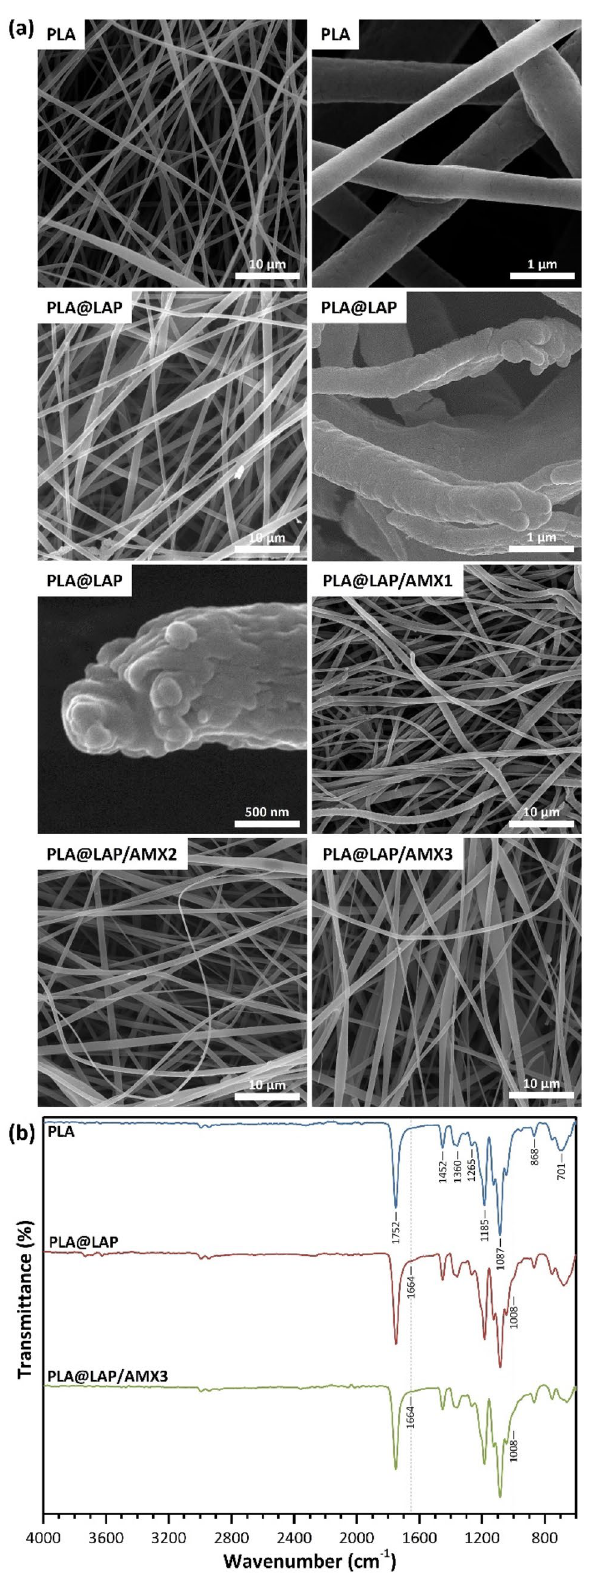
Figure 3. SEM images ( a ) and FTIR spectra ( b ) of